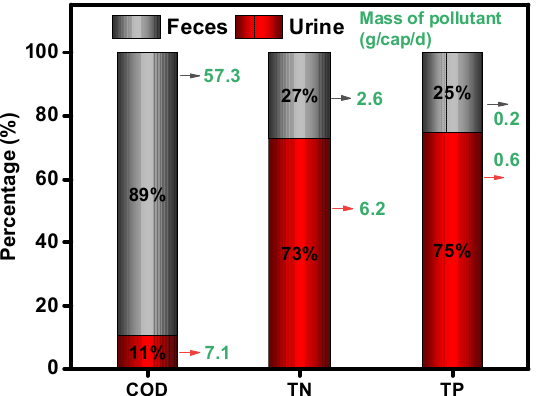
Figure 3. The contribution of excreta and urine for COD, TN, and TP contained in human excreta. TN—total nitrogen, TP—total phosphorus.